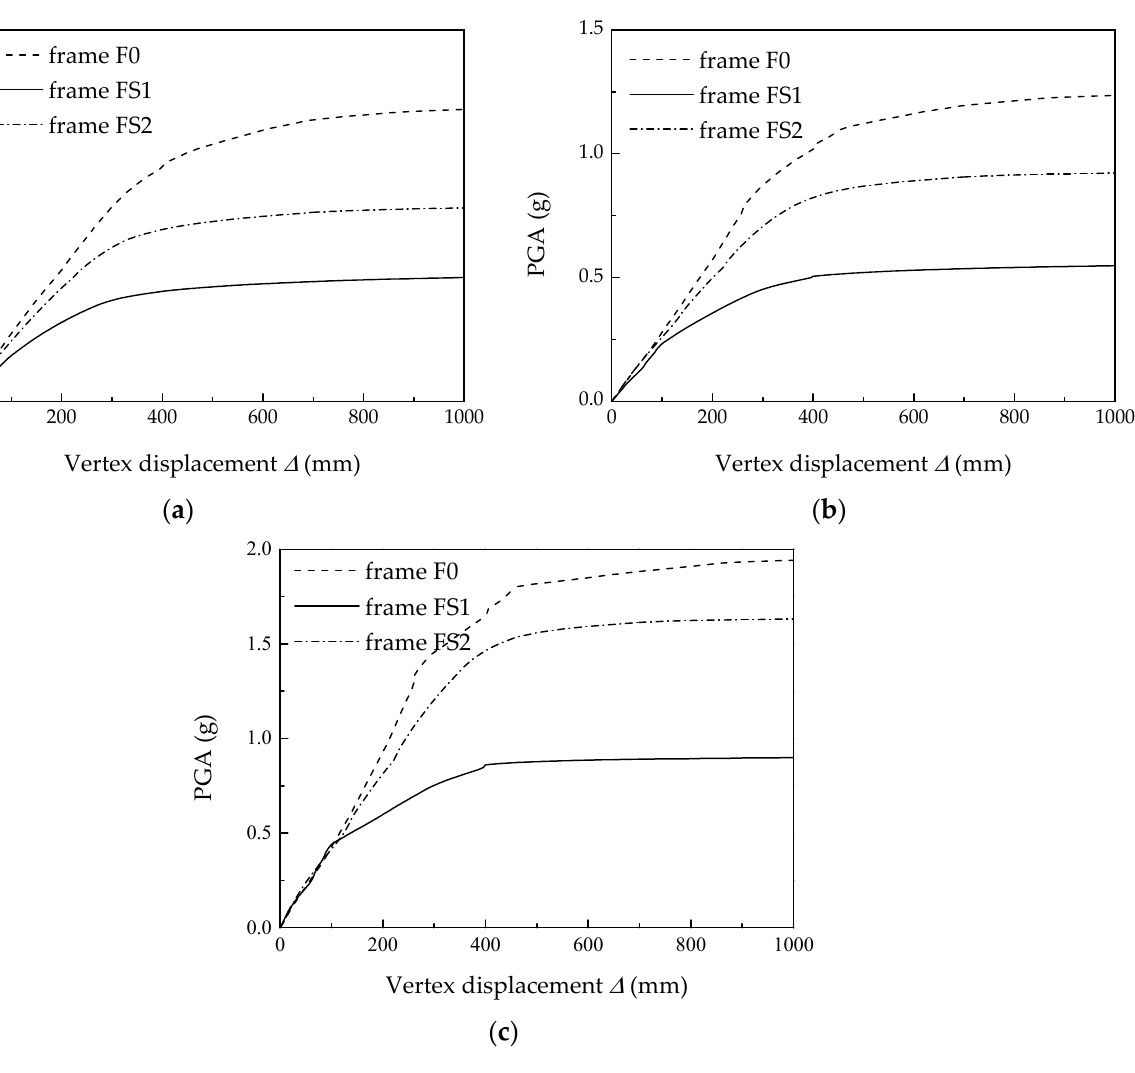
Figure 15. Comparison of the IDA curves of the three different frames. ( a ) 16% quantile; ( b ) 50% quantile; ( c ) 84% quantile.